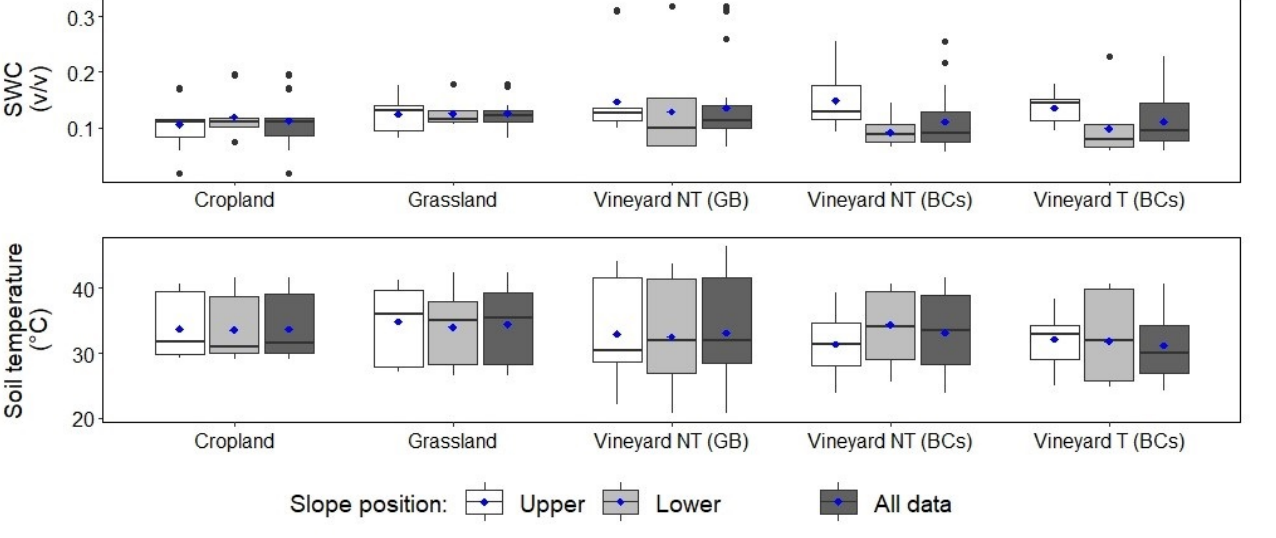
Figure 4. Boxplot of the upper and lower slope points’ data along with land use averages of NDVI, PRI, fAPAR, LAI ( n = 35), SWC ( v / v ), and soil temperature (°C; n = 70). Data showing yearly median (solid black line), mean (blue diamond), upper and lower quartiles, and minimum and maximum values (whiskers; data plus/minus 1.5 interquartile range).